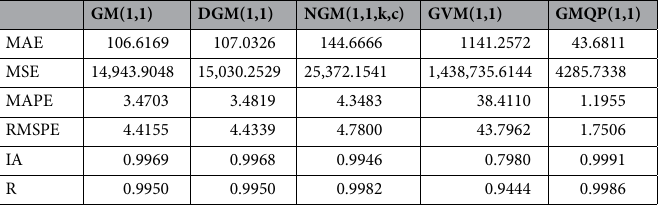
Table 7. The evaluation measures of these models in the electricity consumption of China.